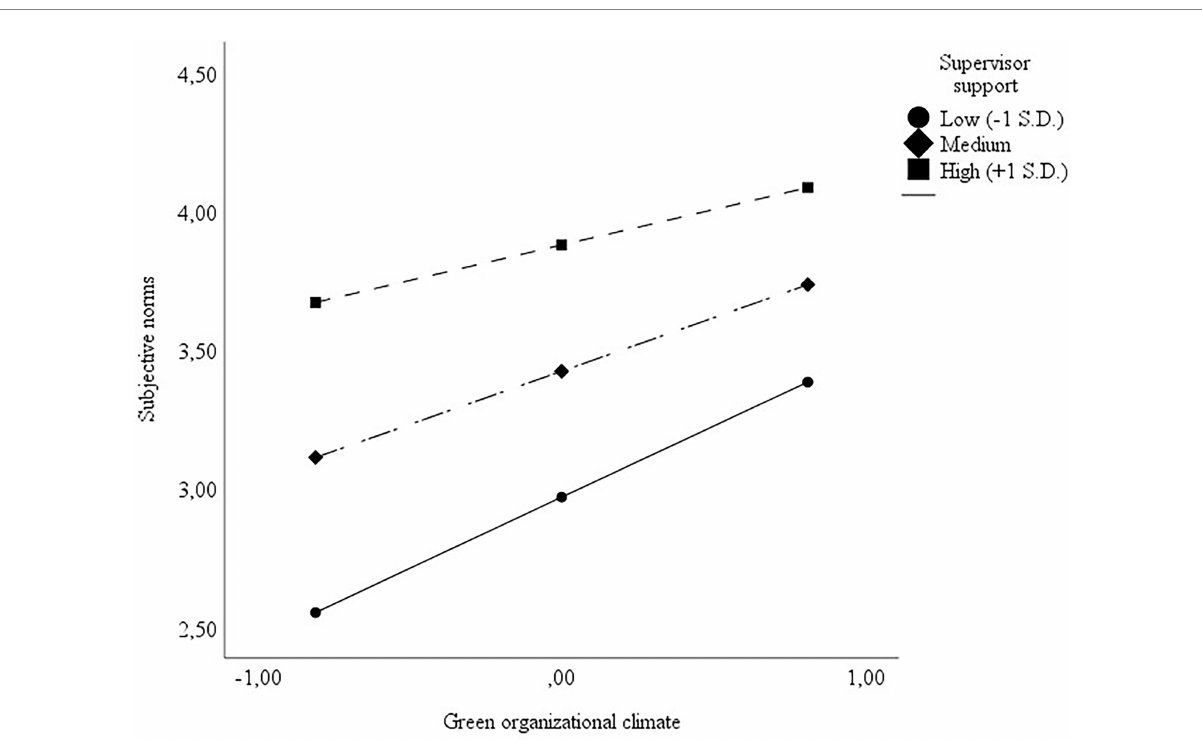
FIGURE 2 Supervisor support’s moderation of the relationship between green organizational climate and subjective norms (for paper